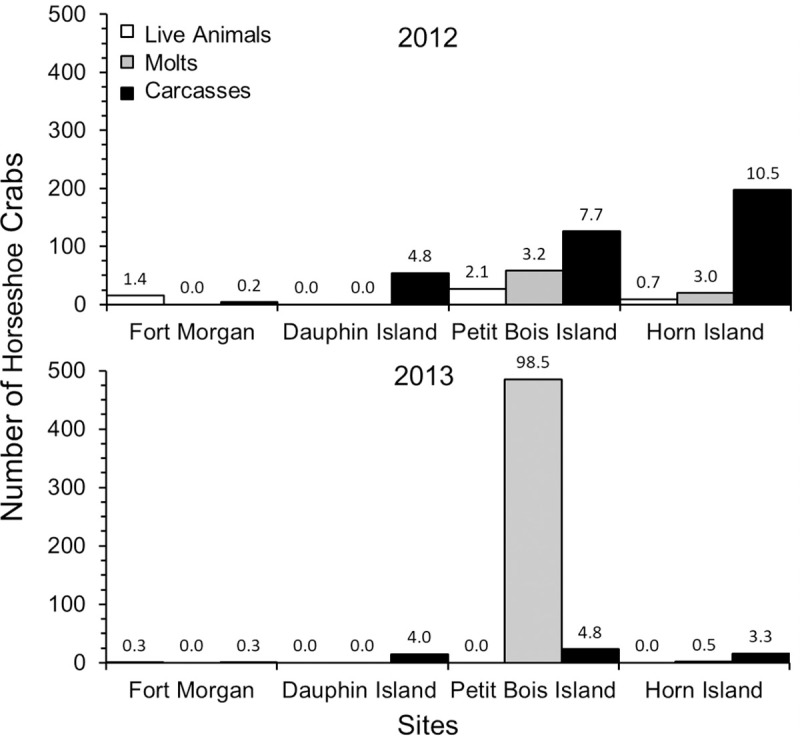
Number of horseshoe crabs (live animals, molts, carcasses) found at each site during surveys in the years of 2012 and 2013.The number of horseshoe crabs found per day is noted above each bar to show occurrence normalized to the level of effort among sites.